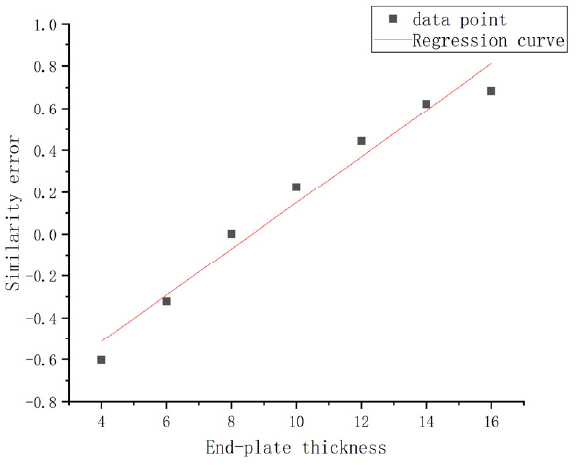
Figure 28. Data points and the regression curve at C w .